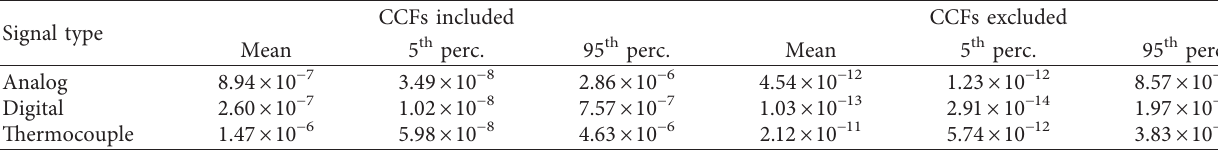
Table 3: Probabilities of the RPS failing to generate a trip signal on demand.